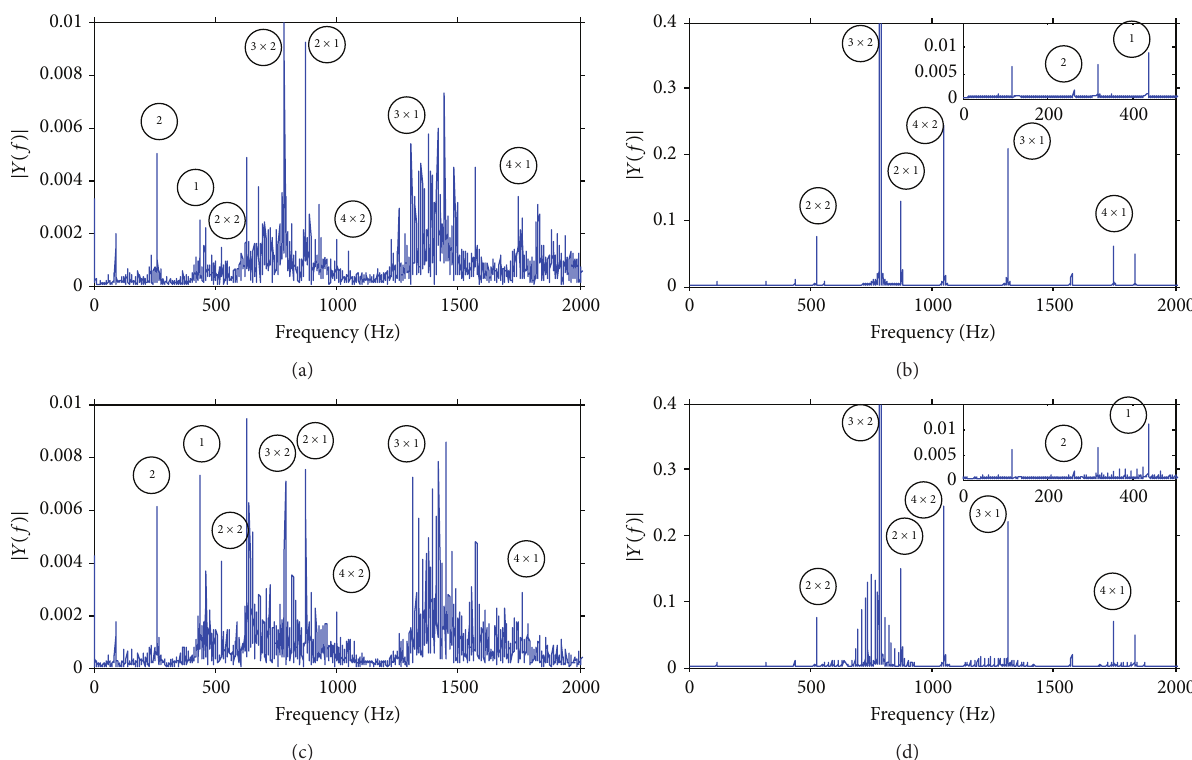
Figure 8: Spectrum analysis of experimental data and model results for 820 rpm constant speed test: (a) healthy data, (b) healthy model, (c) damaged (missing tooth) data, and (d) damaged model. A : 1st-stage gear mesh frequency; B : 2nd-stage gear mesh frequency.